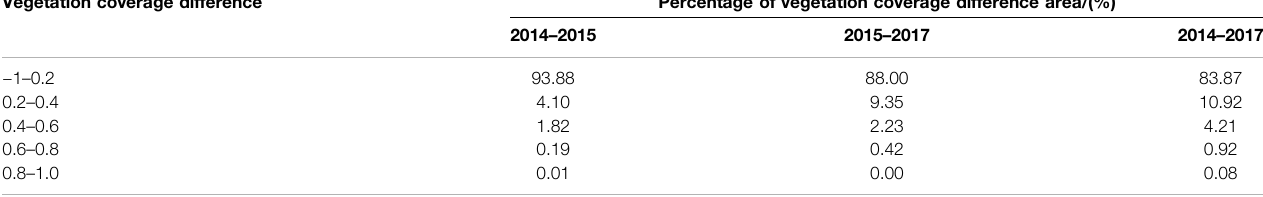
TABLE 3 | Statistics of vegetation coverage